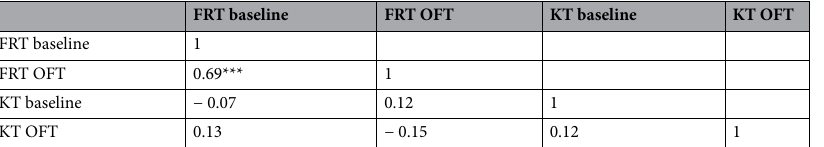
Table 2. Correlations between the FRT and KT for the LI. Numbers indicate correlation coefficients. Asterisks indicate p-values with ***p < 0.001.